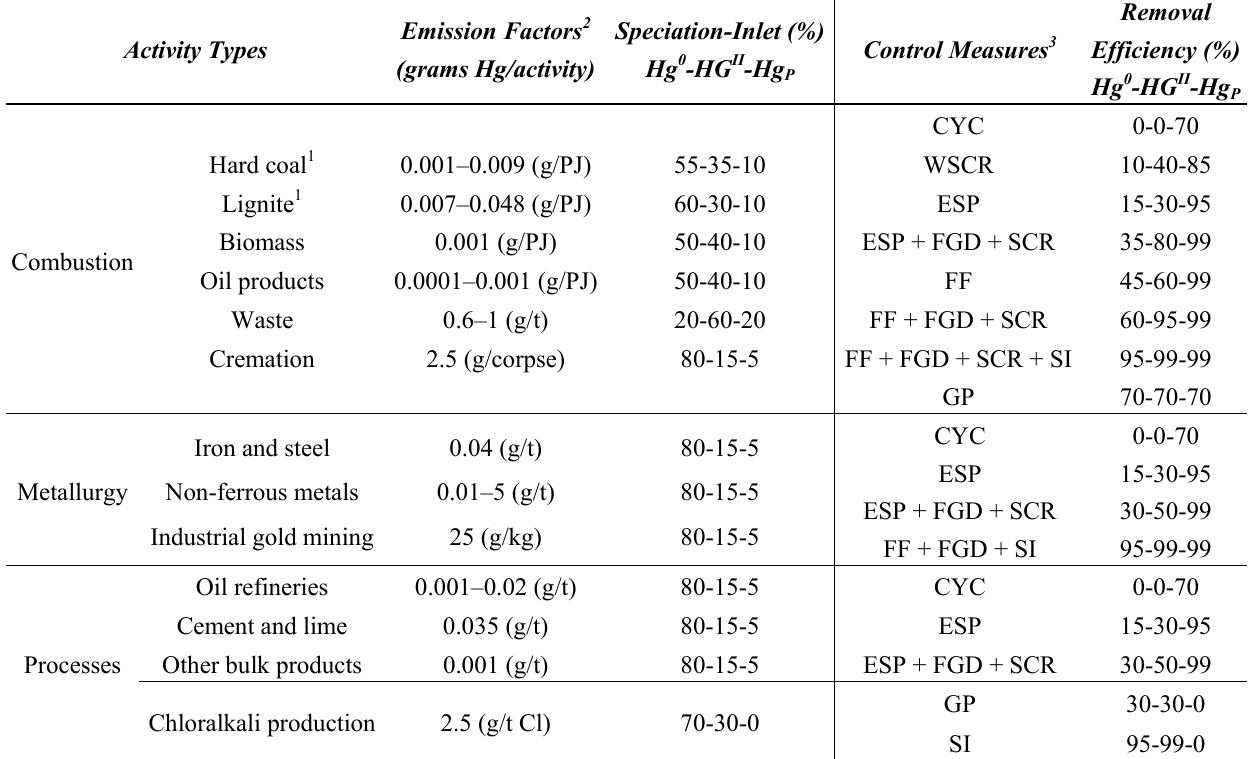
Table 1. Summary of the parameters and characteristics of control options used for Hg calculation in